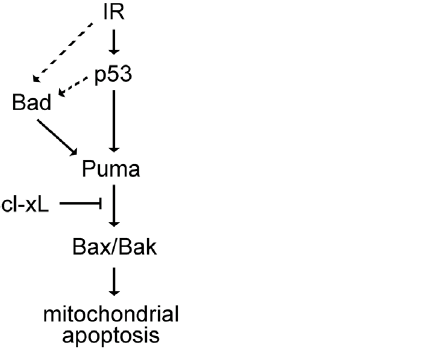
Figure S2 Diagram of zbad genetic knockdown strategies. (A) The zbad b gene (located on zebrafish chromosome 7) contains 4 exons (rectangles) and three introns (adjoining lines between the exons) with start (ATG) and stop (TGA) codons marked in the second and fourth exons, respectively. Primers zbad-for and zbad-rev were designed to amplify the complete coding sequence of the zebrafish bad gene. The bad e2i2 MO was designed to inhibit the splice donor site at the junction of exon 2 and intron 2. The BH3 domain, which is required for Bad pro-apoptotic activity, is encoded at the end of exon 3. (B) One-cell stage embryos were injected with 200 nmol of either mismatch (mm) or bad e2i2 MO. At 24 hpf, RNA was harvested from each group and analyzed by RT-PCR using either bad-for plus bad-rev primers, or primers that amplify b -actin as a loading control. (C) All four bands from the upper agarose gel pictured in (B) were excised and cloned into pGEM-T-easy for subsequent sequencing. The transcript resulting from each band is diagrammed based on sequencing results. The bad e2i2 MO causes both inclusion of intron 2 and an in-frame deletion in exon 2, as well as production of low levels the wild-type bad transcript. Expected translation products are shown below the observed transcripts. The D 18 deletion (represented by the 413-bp band in (B)) is expected to include the BH3 domain and could possibly give rise to a functional Bad protein. These results show that the bad e2i2 MO induces an on-target, albeit incomplete, knockdown of the zbad gene. Figure S3 Wild-type Bad synergizes with wortmannin to induced embryonic death. Shown are brightfield views of representative wells from a 12-well plate demonstrating morpho- logical changes observed in the experiment quantified in Figure 2D. WM; wortmannin. Figure S4 Bad-mediated radiosensitization does not alter the timing of IR-induced apoptosis. One-cell stage embryos were injected with 50 pg mRNA encoding mcherry (cntl) or hBAD . At 24 hpf, half of each group was irradiated with 8 Gy IR and analyzed one, two, and three hours later by the Casp3 assay. Fluorescence intensity was measured in the spinal cords of at least 10 embryos from each group, and the fluorescence intensity in control-injected embryos at 3 hpIR was normalized to 1. Table S1 Sequences of primers and morpholinos used in the experiments described in this study.